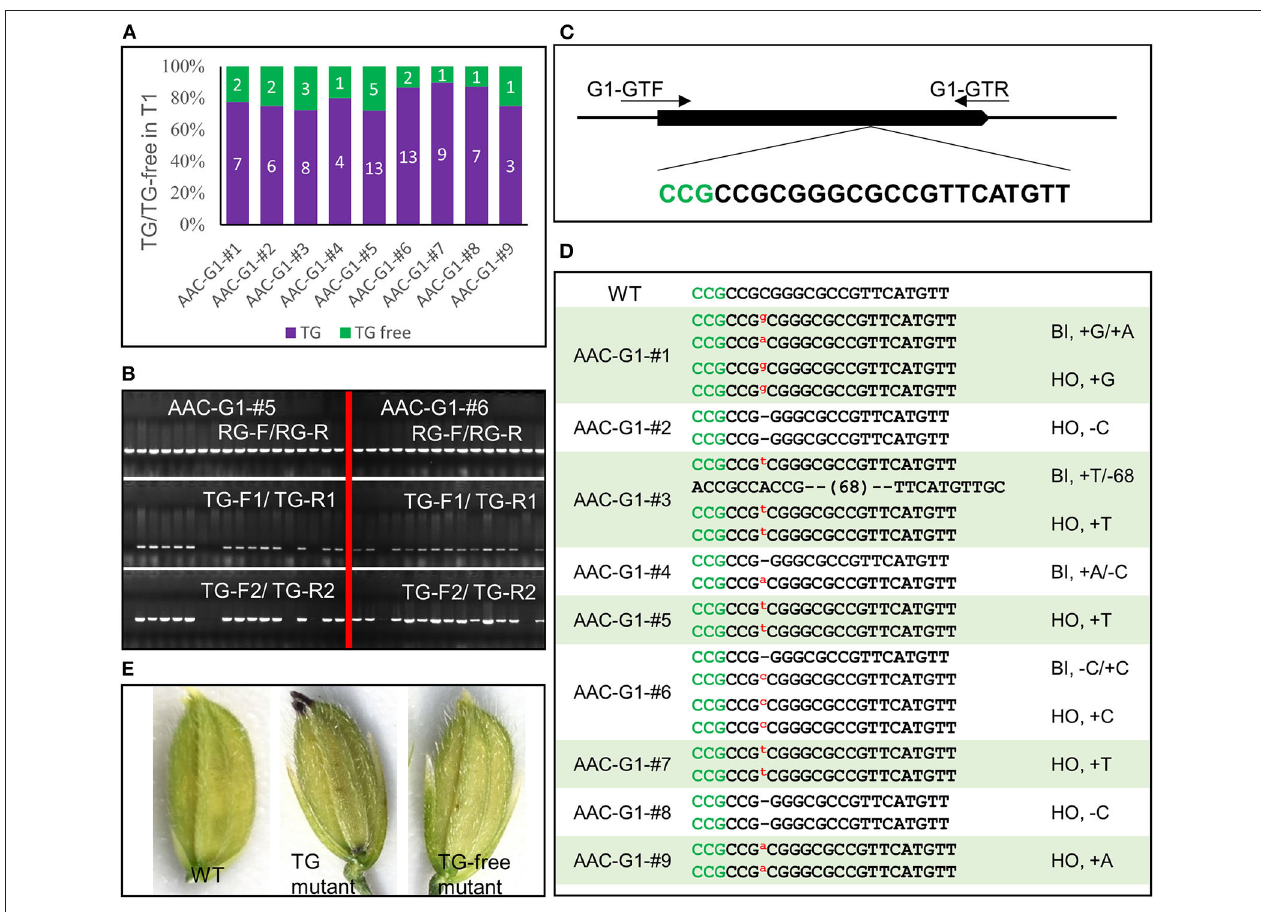
FIGURE 5 | Identification transgene-free and gene-edited g1 mutants. (A) The segregation of the transgene (TG) and transgene-free (TG-free) plants from 9 AAC-G1 T1 lines. The numbers on purple and green columns represent the numbers of purple and normal color plants in T1 lines which were consistent with the results identified by PCR, respectively. (B) The transgene-free plants from the progeny of the purple-colored T0 plants were identified by PCR. AAC-G1–#5 and AAC-G1-# 6 refer to two AAC-G1 T0 plants containing the purple color, respectively. “RG-F/RG-R” refers to primer pair used for checking the quality of rice genome DNA. “TG-F1/TG-R1” and “TG-F2/TG-R2” represent two primer pairs used for detection the presence of T-DNA, respectively. The primers information was described in Supplementary Table 3 . (C) Target site of G1 used in AAC-G1 plasmid. A target sequence including the PAM site CCG (marked green) was chosen. G1-GTF and G1-GTR are the genotyping primer pair of G1 CRISPR plants. Primers were listed in Supplementary Table 3 . (D) The mutation forms of the transgene-free and CRISPR-edited g1 mutants. The PAM site “CCG” required for Cas9 cleavage is marked in green. “WT” refers to the wild-type plants. “HO” and “BI” represent homozygous and bi-allelic genotypes, respectively. “-” refers to a deletion of one base pair. “a,” “g,” “c” and “t” in red and superscript refers to an insertion of an “A,” “G,” “C,” and “T,” respectively. (E) The g1 mutant florets with (TG) or without transgene (TG-free) generated by